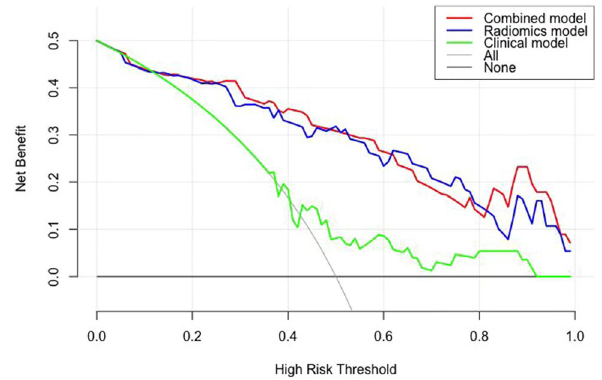
Figure 6. The survival probability of high-grade PMP and low-grade